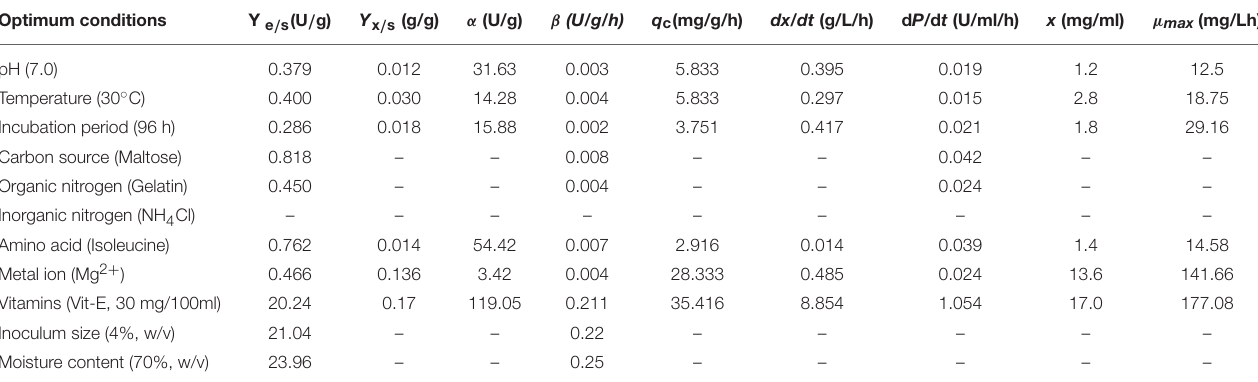
TABLE 7 | Fermentation kinetics of biosynthesized amylase. Optimum